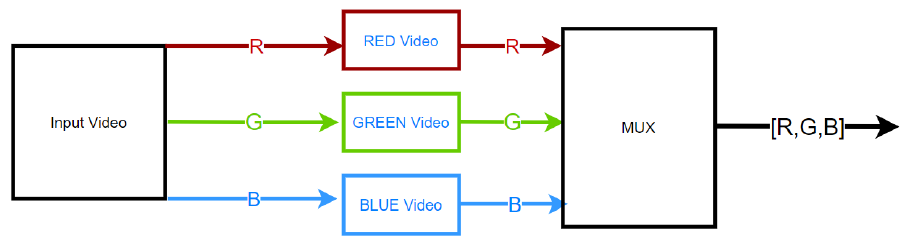
Figure 8. Handling of the video content in the RGB mode.